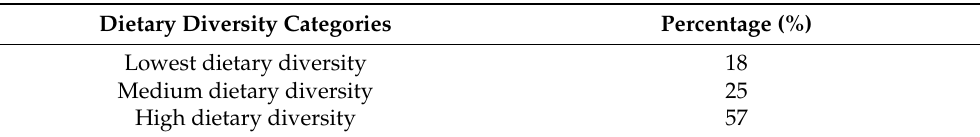
Table 2. Dietary diversity of smallholder farmers in Limpopo ( n = 911) and Mpumalanga ( n = 609) Provinces, South Africa.